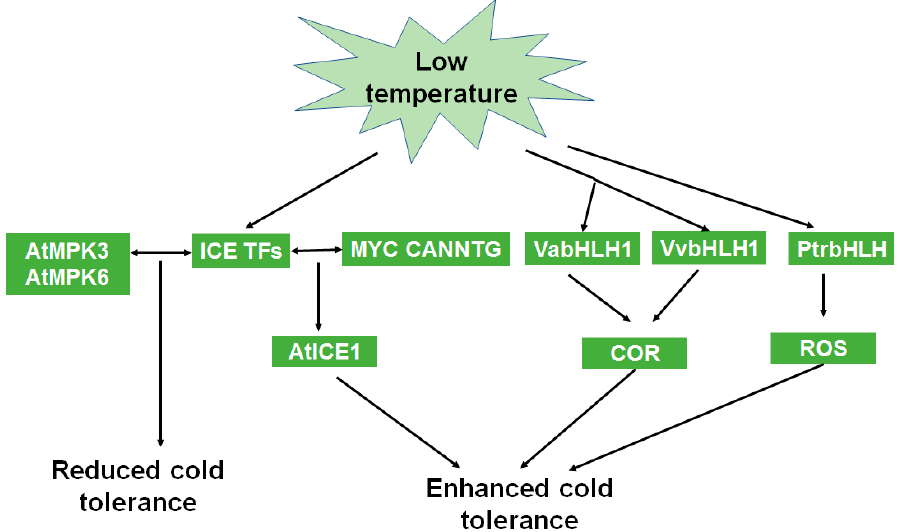
Figure 3. Model of the roles of bHLHs in cold stress tolerance.